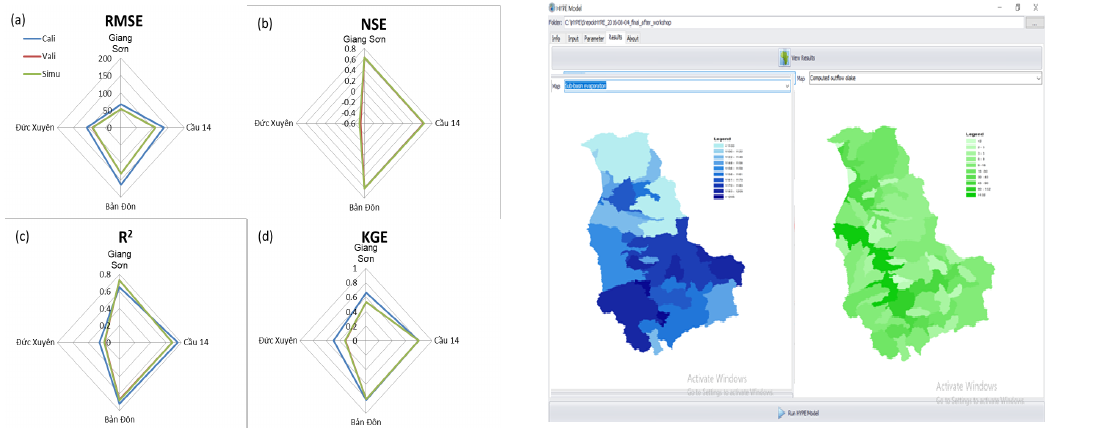
Fig. 9: HYPE model accuracy evaluation using error co- e(cid:30)cients: (a) RMSE, (b) NSE, (c) R 2 , and (d) KGE.